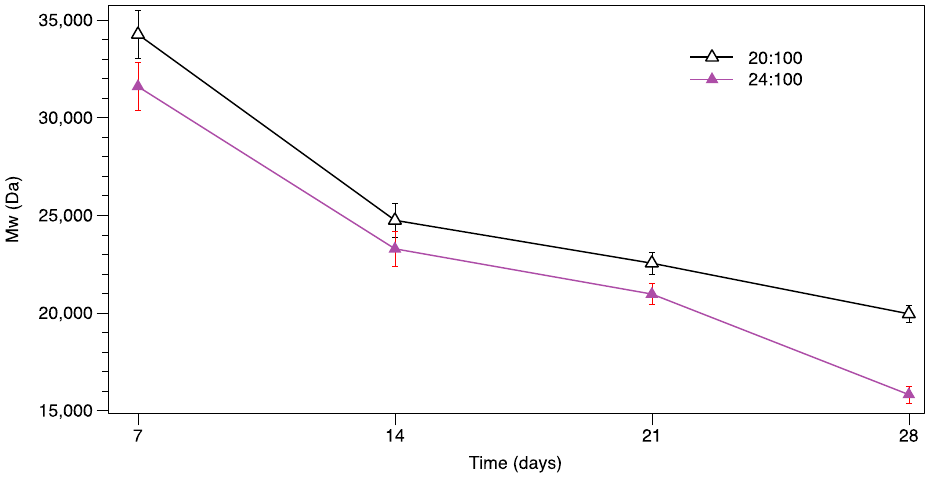
Figure 5. Time trend of for 20–100 and 24–100 (PLGA—only) MPs.